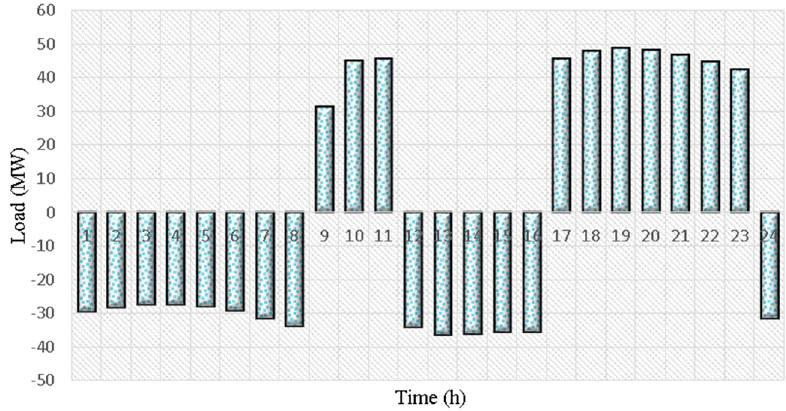
Figure 9. Difference between the demand level and the actual electricity consumption over the scheduling time horizon.